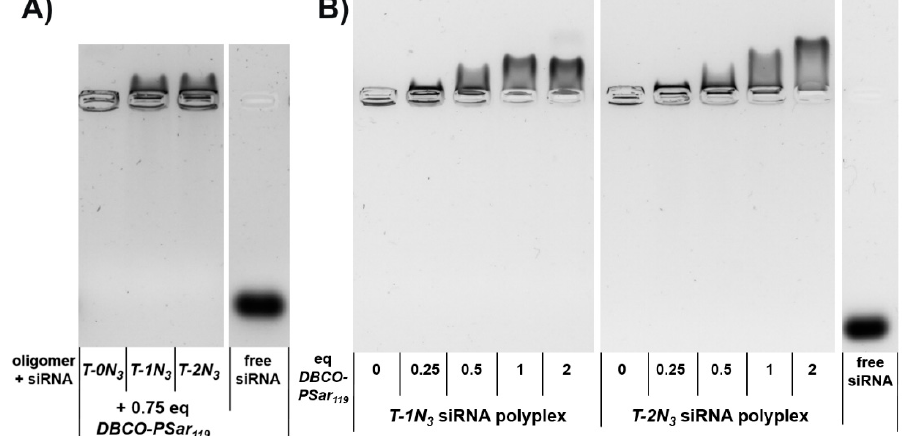
Figure 2. Electrophoretic mobility of siRNA lipopolyplex formulations analyzed with an agarose gel shift assay ( A ) siRNA polyplexes formed with lipo-oligomers bearing no ( T-0N 3 ), one ( T-1N 3 ) and two ( T-2N 3 ) azide functions incubated with 0.75 equivalents of DBCO-pSar 119 1% agarose gel, 70 V, 80 min runtime; ( B ) Formulations with increasing equivalents (eq mol/mol) of DBCO-pSar 119 . 0.75% agarose gel, 100 V, 80 min runtime. Polyplexes were incubated for 40 min at N / P 12, followed by DBCO-pSar 119 addition for 16 h at room temperature. The right lane in each gel shows the running distance of free siRNA not complexed by lipo-oligomers.